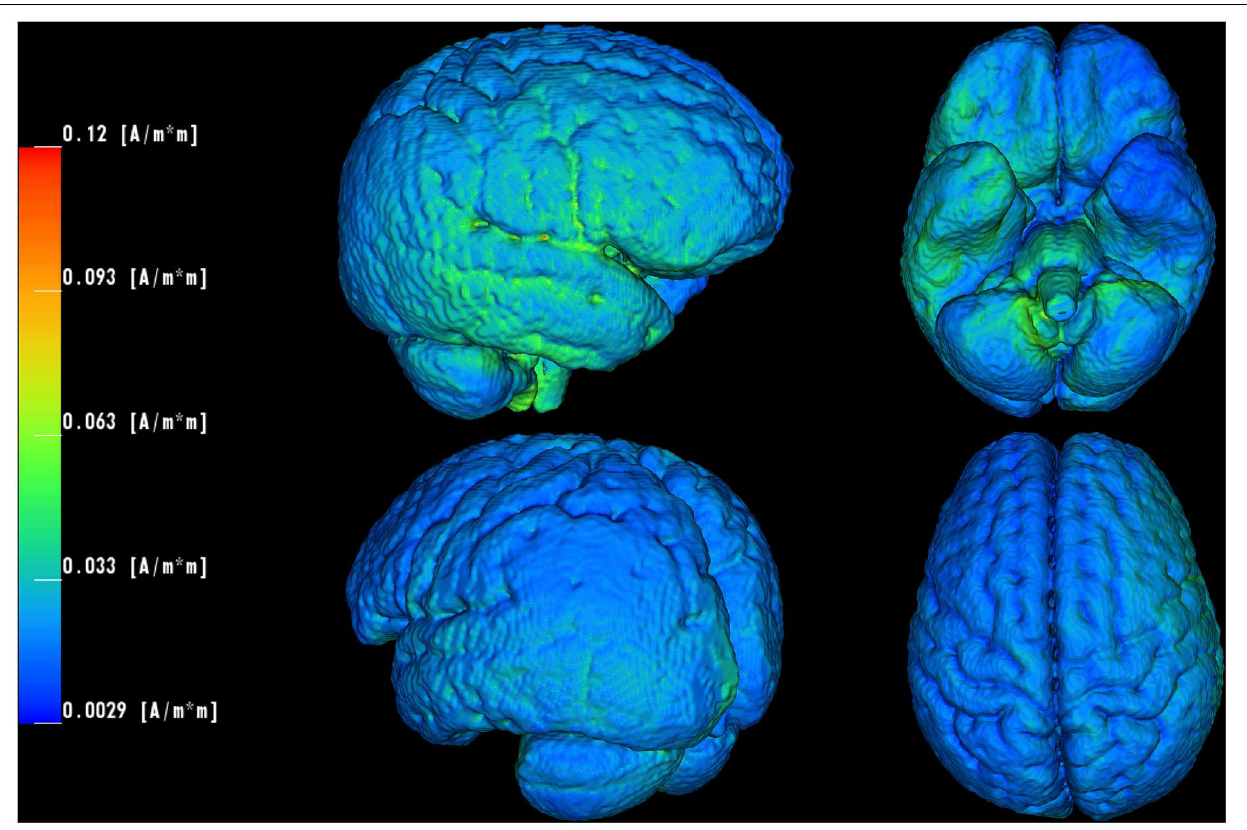
FIGURE 4 | Computer simulation of the utilized tDCS electrode settings. Current density concentrations are visualized on brain surface of the employed pediatric head model. The current density values are peaking locally in frontal/temporal (maximum: 0.12 A/m 2 ), brain stem and lower cerebellar (near foramen magnum)